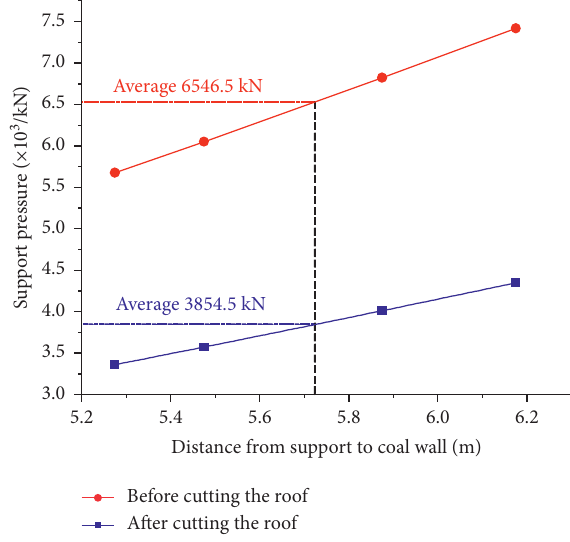
Figure 6: Change curve of the working resistance of the support before and after